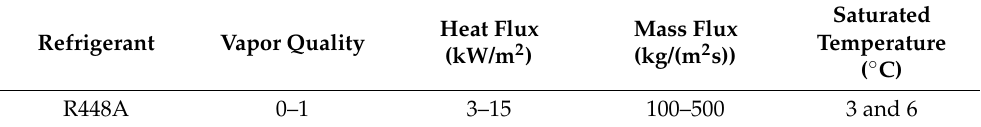
Table 2. Experimental conditions.